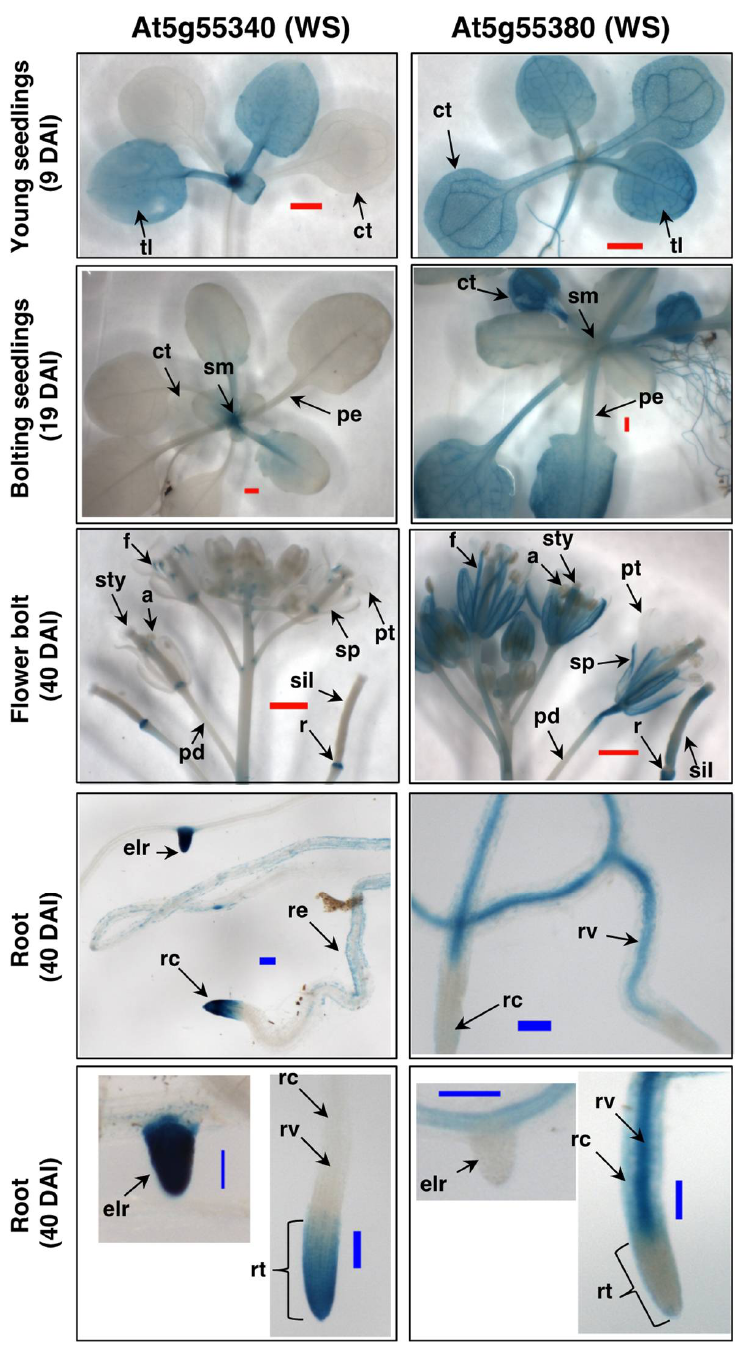
Figure 5. Characterization of WS gene expression with promoter-GUS transgenes. GUS activity in transgenic plants carrying promoter-GUS fusions for the WS genes At5g55340 and At5g55380. Plant organs, and ages of the plants are indicated as days after imbibition (DAI). Identified tissues are: anthers (a); emerging lateral root (elr); filament (f); pedicle (pd); petiole (pe); petal (pt); receptacle (r); root cortex (rc); root cap (rcp); root epidermis (re); root tip (rt); root vasculature (rv); shoot meristem (sm); sepal (sp); stigma (st); style (sty); and true leaf (tl). Scale bars represent: 1 mm (red bar) and 0.1 mm (blue bar).